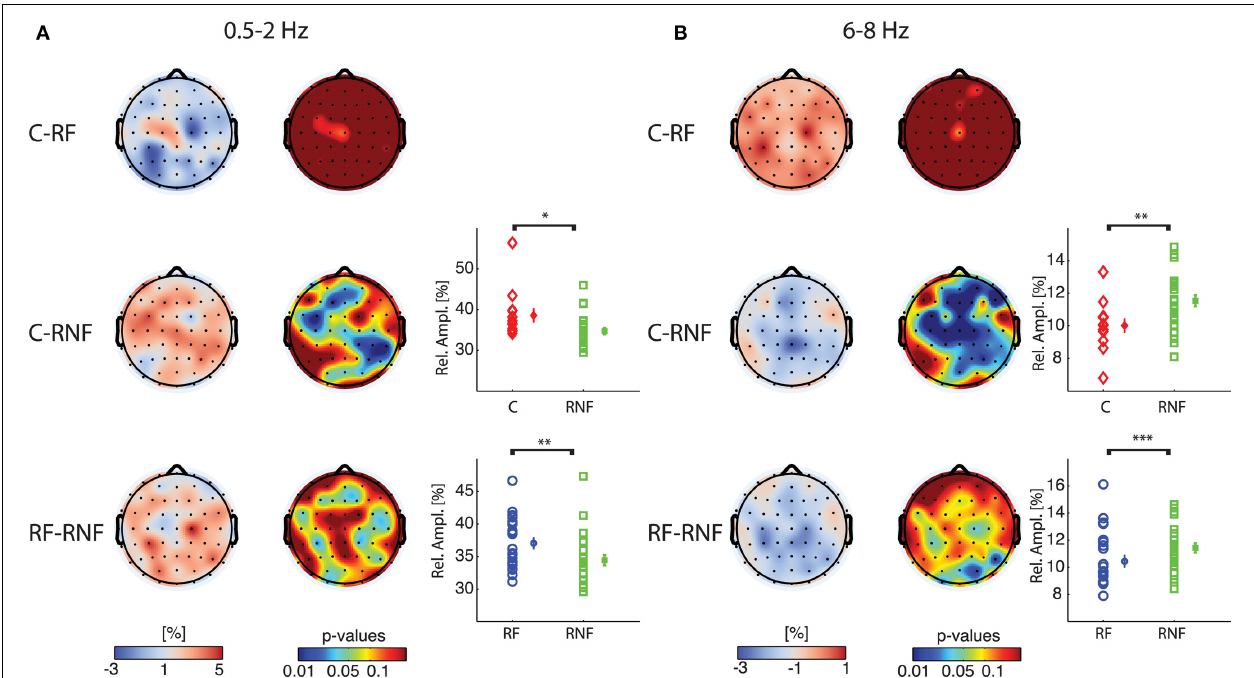
FIGURE 3 | At-risk non-fluent readers have altered delta-1 and alpha-1 compared to control and at-risk fluent readers. Pair wise group statistics (rank-sum tests) are displayed for relative amplitude for delta-1 (A) and alpha-1 (B) . In the first column: topographies of the difference of grand median values (cool-warm colormap) between controls and at-risk fluent readers (C-RF) in the firstrow,betweencontrolsandat-risknon-fluentreaders(C-RNF)inthesecond row, between at-risk fluent readers and at-risk non-fluent readers (RF-RNF) in